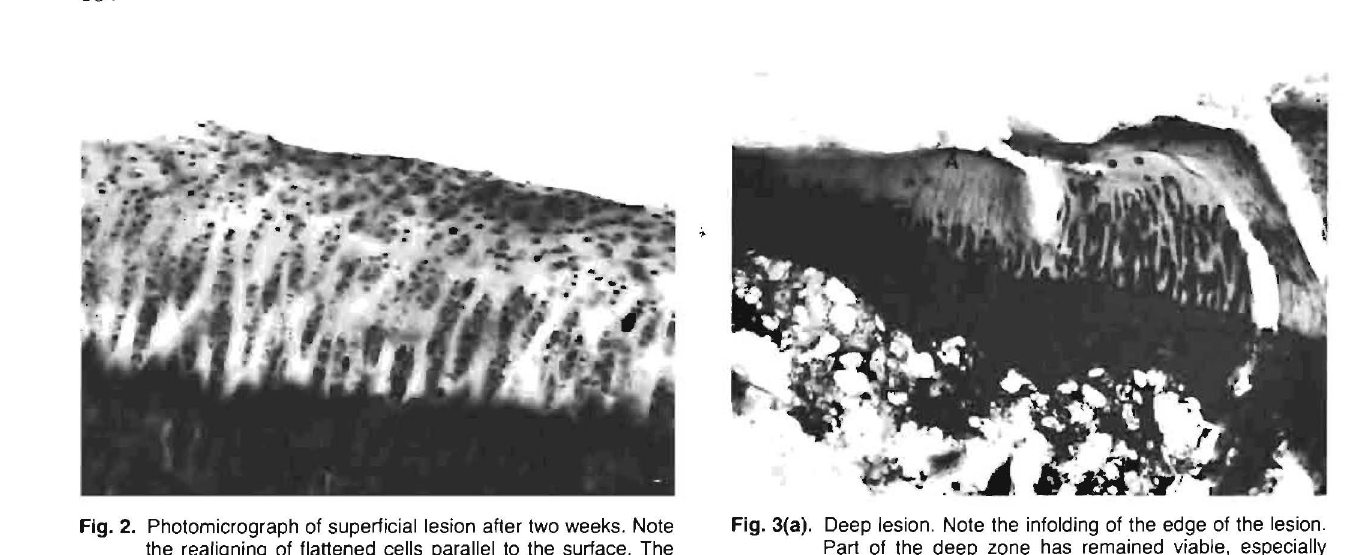
Fig. 2. Photomicrograph of superficial lesion after two weeks. Note the realigning of flattened cells parallel to the surface. The transitional and deep zones are reduced in thickness. (x 150)